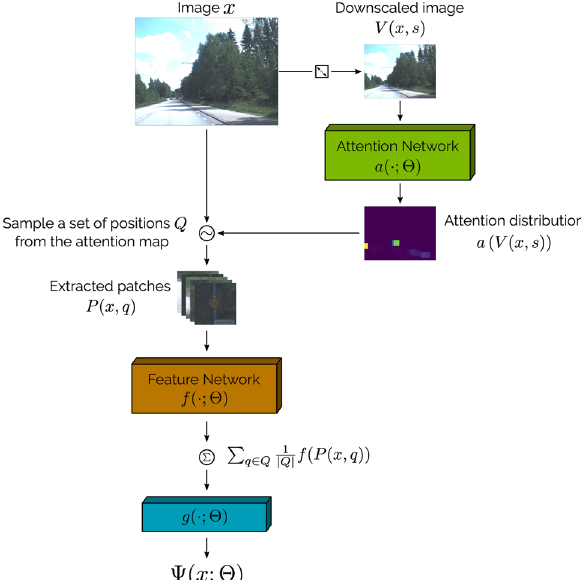
Fig. 6 Deep Attention Sam- pling methodology, obtained from [17]